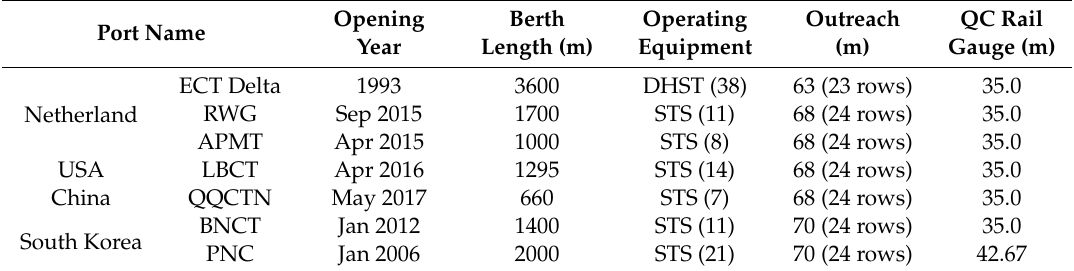
Table 11. Automated Terminal Operating Equipment and QC Rail Gauge in International Ports.